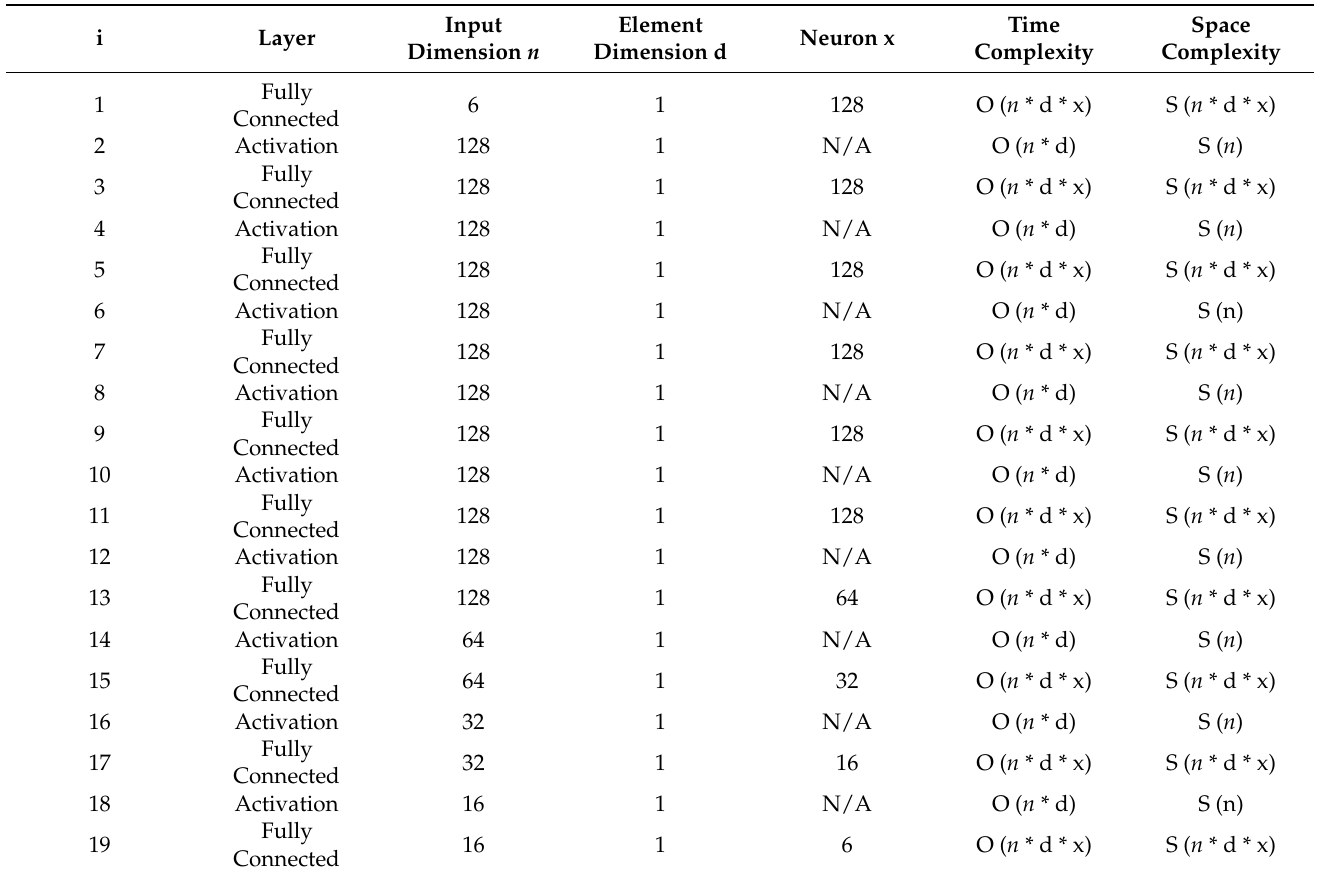
Table 3. Inverse kinematics complexity